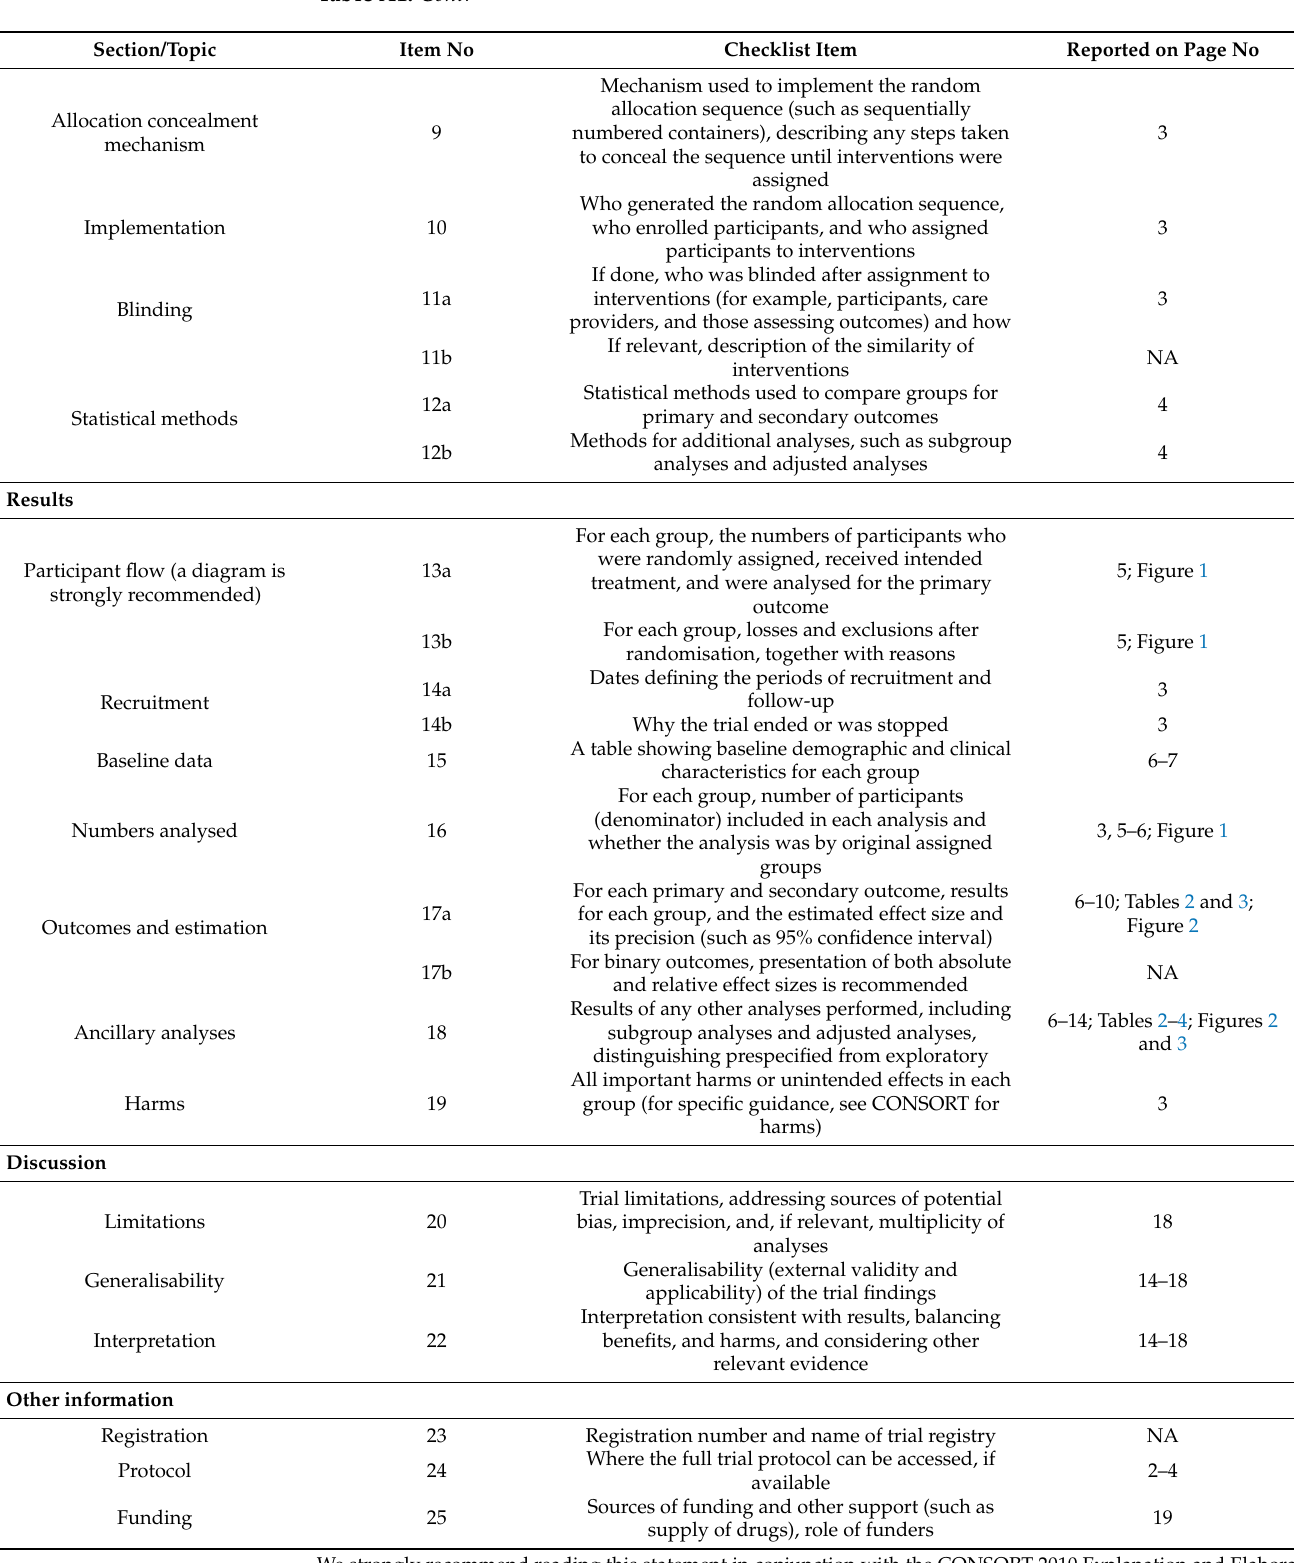
A table showing baseline demographic and clinical characteristics for each